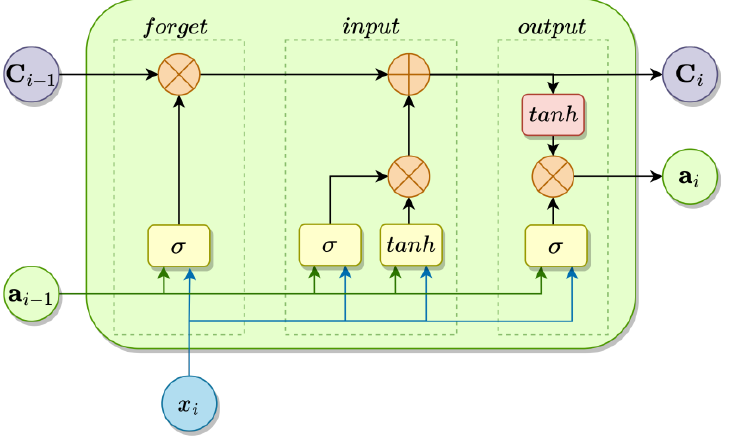
Figure 5. LSTM unit structure.